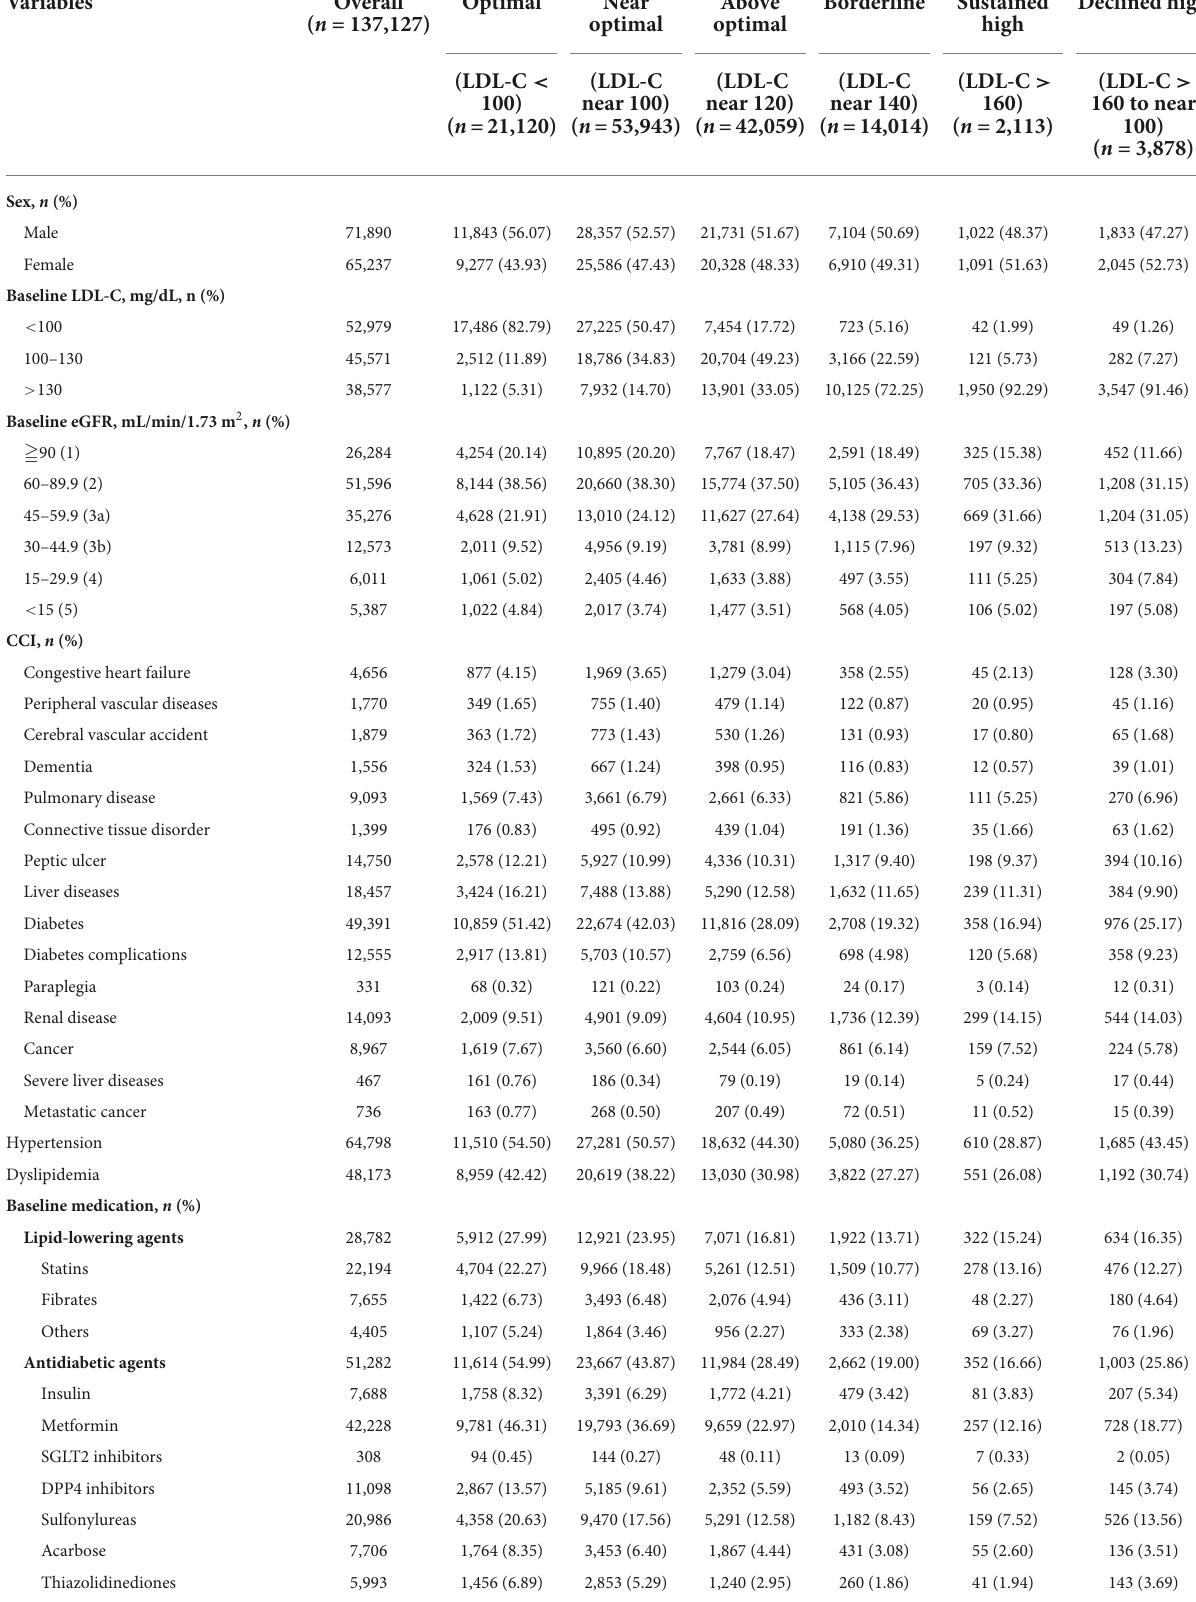
TABLE 1 Baseline characteristics of the chronic kidney disease cohort by LDL-C trajectory class and baseline risk category.